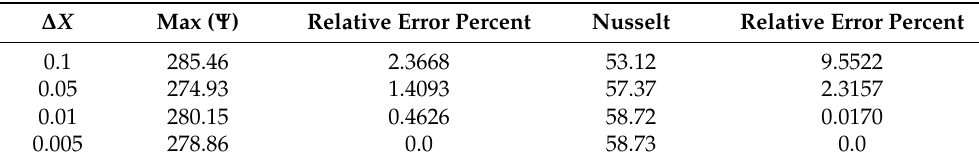
Table 3. Grid dependence tests at N = 11, A R = 1 and N r = 55.31.